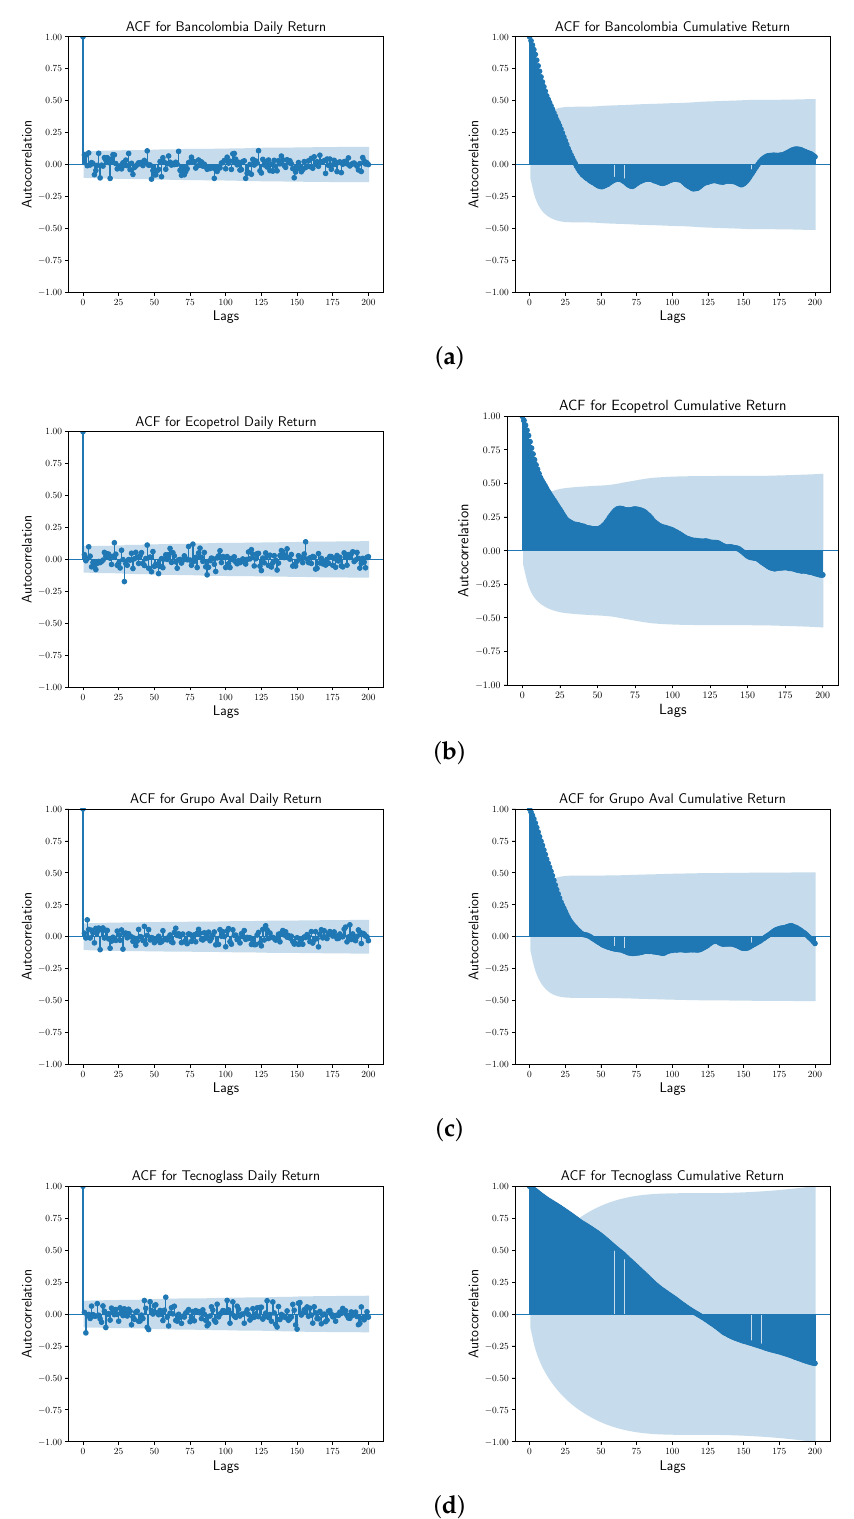
Figure 2. Autocorrelation plots for ( a ) Bancolombia, ( b ) Ecopetrol, ( c ) Grupo Aval, and ( d ) Tecnoglass time series data—daily returns (left) and cumulative returns (right). The dashed blue line specify a significance threshold. Lags, consistently outside the pair of dashed blue lines, represent non- stationary